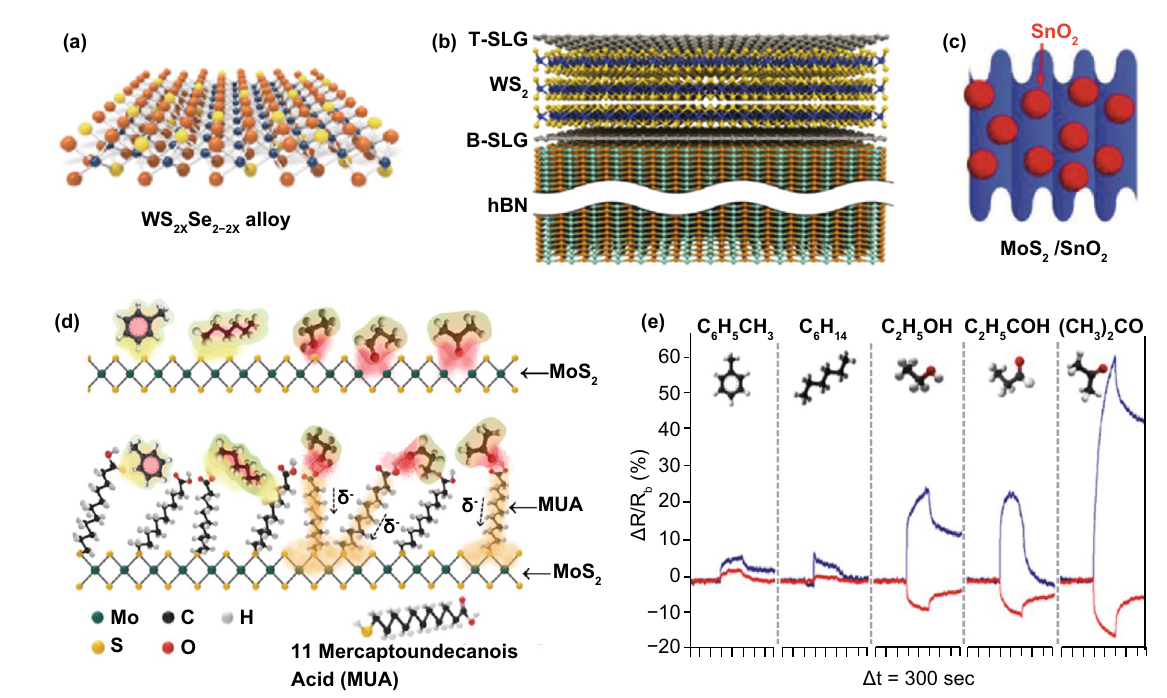
Fig. 4 2D TMDC FET sensor for chemical vapors detection. Modifications on TMDC channel to tune the gas sensing performance, including a TMDC alloys, b heterojunctions, and c MoS 2 -nanoparticle composites. Reprinted with permission from Ref. [103], Copyright 2015, Ameri- can Chemical Society; Ref. [104], Copyright 2017, Royal Society of Chemistry; Ref. [12], Copyright 2015, Wiley. Sensing for various VOCs on pristine and functionalized MoS2 channel: d schematic of adsorption-based sensing mechanism and e the comparison of real-time sensing responses to different chemical vapors (blue line: pristine MoS 2 , red line: mercaptoundecanoic acid/MUA-modified MoS 2 ). Reprinted with per- mission from Ref. [18], Copyright 2014, American Chemical Society. (Color figure